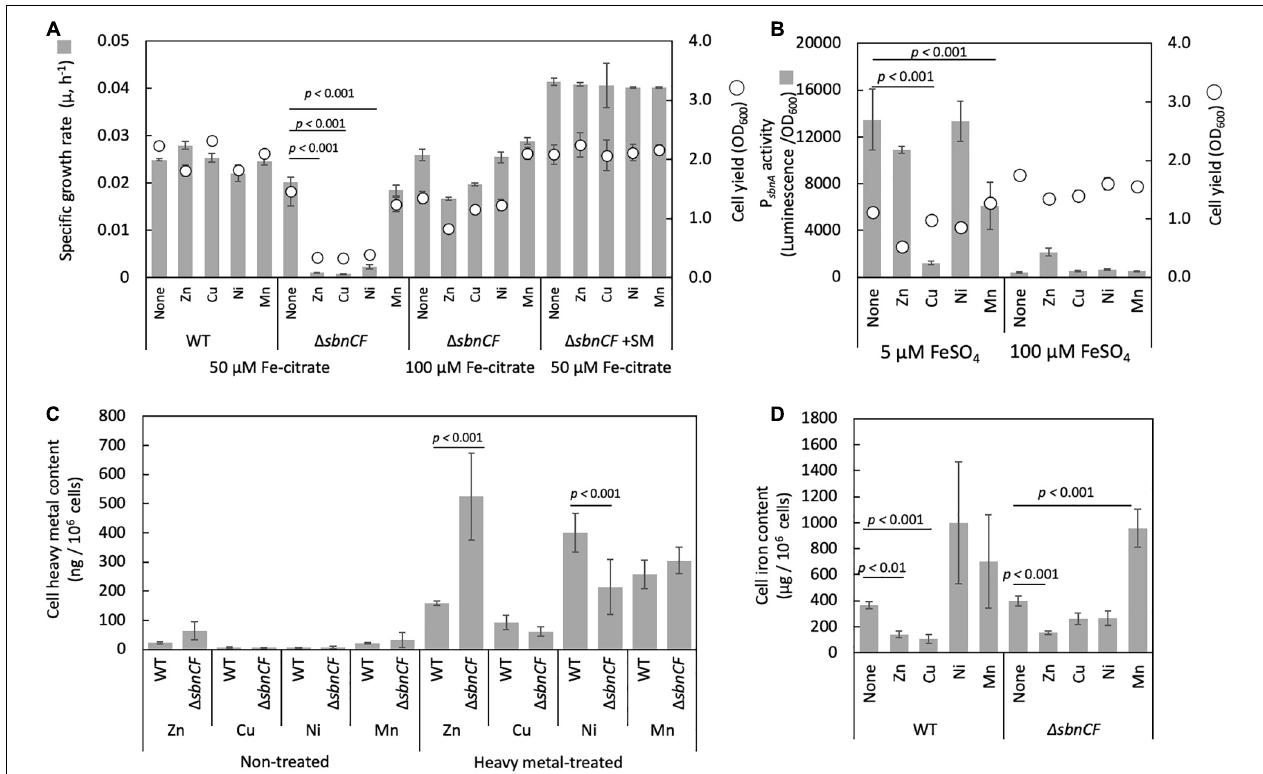
FIGURE 5 | (A) Growth of the wild-type strain 22A and (cid:49) sbnCF on succinate in the presence of 100 µ M of ZnSO 4 , CuSO 4 , NiSO 4 , and MnSO 4 under 50 µ M iron citrate, growth of (cid:49) sbnCF under 50 µ M under 100 µ M iron citrate. Growth of (cid:49) sbnCF on succinate in the presence of 100 µ M heavy metals under 50 µ M iron citrate supplemented with 22A wild-type spent media. (B) P sbnA activity in the wild-type strain 22A in the presence of 100 µ M of each heavy metal under 5 and 100 µ M FeSO 4 . (C) Heavy metal accumulation in the wild-type strain 22A and (cid:49) sbnCF cells supplemented with 25 µ M heavy metals (HM) or without (NT). (D) Iron accumulation in the cells of wild-type strain 22A and (cid:49) sbnCF grown on succinate in the presence of 25 µ M of ZnSO 4 , CuSO 4 , NiSO 4 , and MnSO 4 , under 100 µ M iron citrate. Data represent the mean of three replicates ± standard deviation